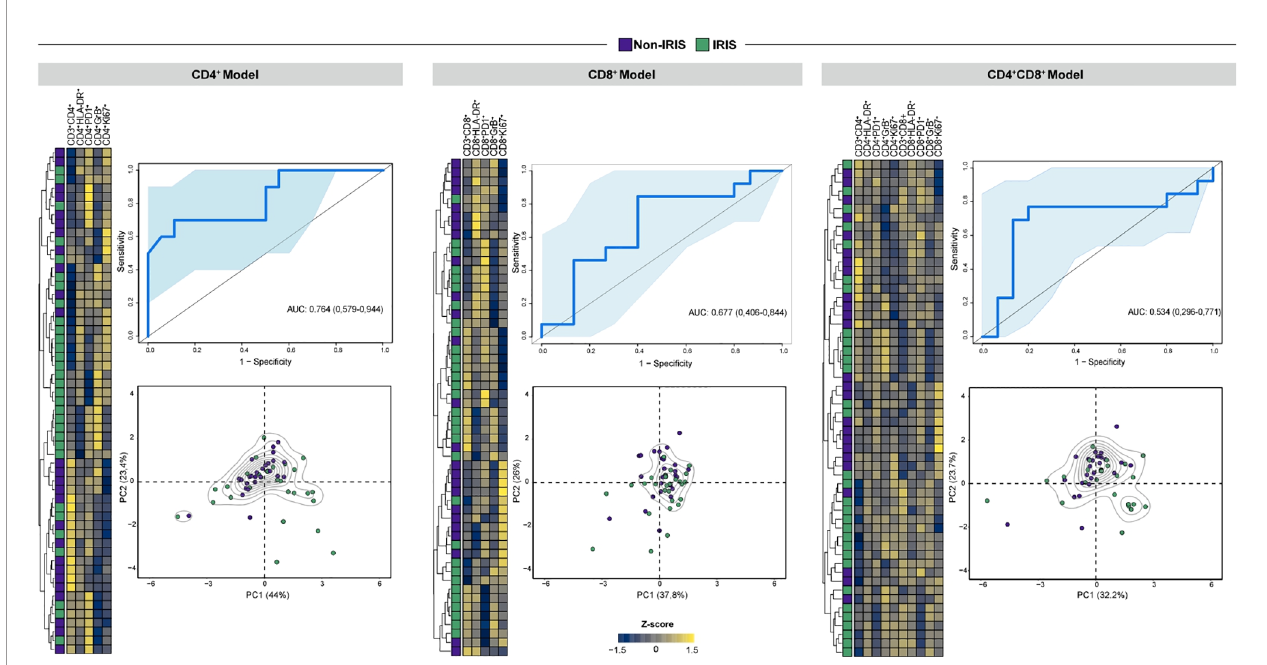
FIGURE 5 | Assessment of CD4+ and CD8+ T lymphocyte activation markers to predict TB-IRIS prior to ART. In order to create predictive models that distinguish TB-IRIS from non-IRIS patients prior to ART, unsupervised machine learning techniques were employed for either CD4 + or CD8 + T cell activation markers. In addition, a model encompassing both CD4 + and CD8 + T cell activation markers was also created. For each model, unsupervised cluster analyses (Ward ’ s method) and principal component analyses were employed. In order to estimate the accuracy of these models in discriminating patients, a receiver-operating characteristic curve analysis was